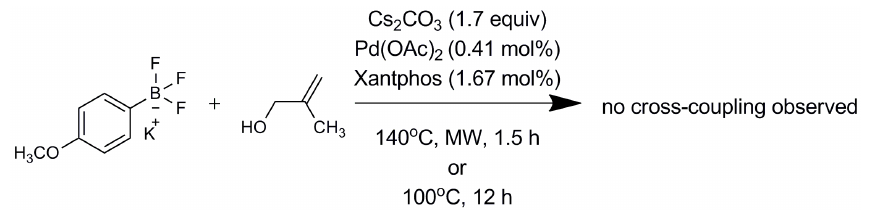
Figure 3. Reactions of 2-methyl-2-propen-1-ol with potassium phenyltrifluoroborate.